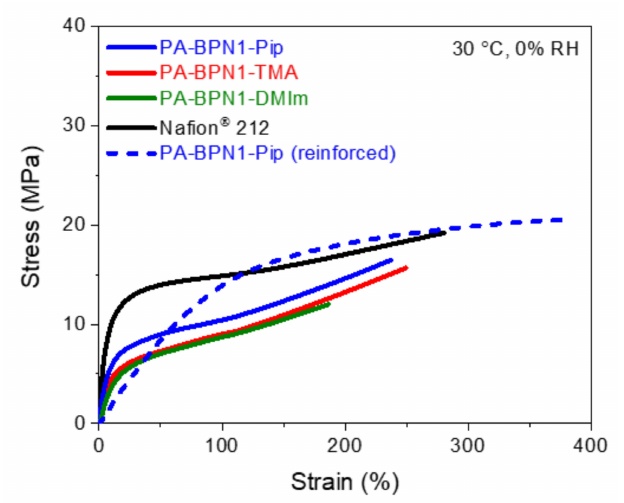
Figure 8. Comparison of stress-strain curves of PA-BPN1-TMA, PA-BPN1-Pip, PA-BPN1-DMIm, Nafion ® 212, and polyethylene-reinforced PA-BPN1-Pip obtained at 30 ◦ C and 0%